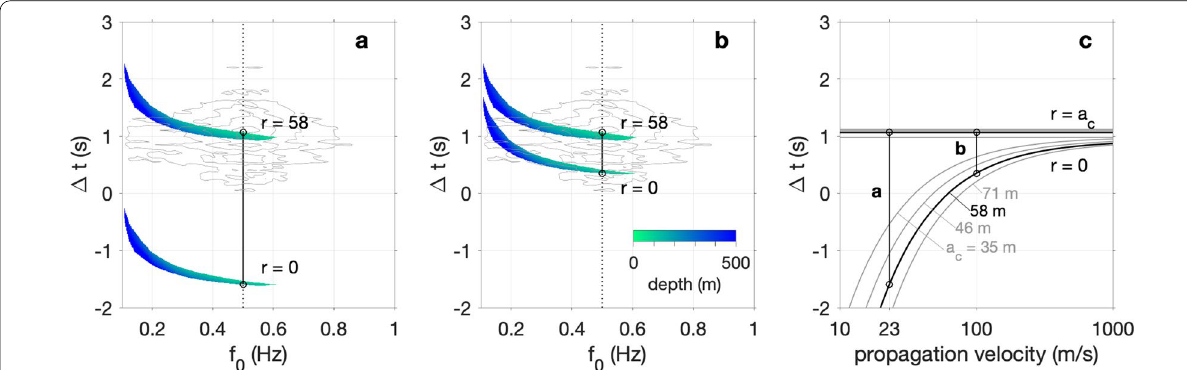
Fig. 7 Ranges of the observed parameters that can provide realistic solutions for two source positions. a, b The colored arcuate areas show the ranges of the observed parameters ( f 0 and (cid:31) t ) with realistic solutions of the combined equation, assuming that the source positions of the explosions are at the center ( r = 0 ) and the margin ( r = 58 ) of the lava pond. The colors show the values of the estimated depth, as in Fig. 4b. The gray contours show the PDF distribution of the observed parameters (Fig. 4). Here, two cases are shown, where the seismic propagation velocities = 0.5 Hz (dotted line), (cid:31) t when the source is at the center is smaller than f v 0 p0 are a 23 m/s and b 100 m/s. For simplicity, focusing on a case of that when the source is at the margin. If the source position changes within 0 ≤ r ≤ 58 , the range of (cid:31) t between the upper and lower bounds (black circles) can be reproduced in our model. c Ranges of (cid:31) t between the bounds. The range narrows as v p0 increases. However, the upper bound remains the same with increasing v p0 . The range also depends on the assumed radius of the lava pond a